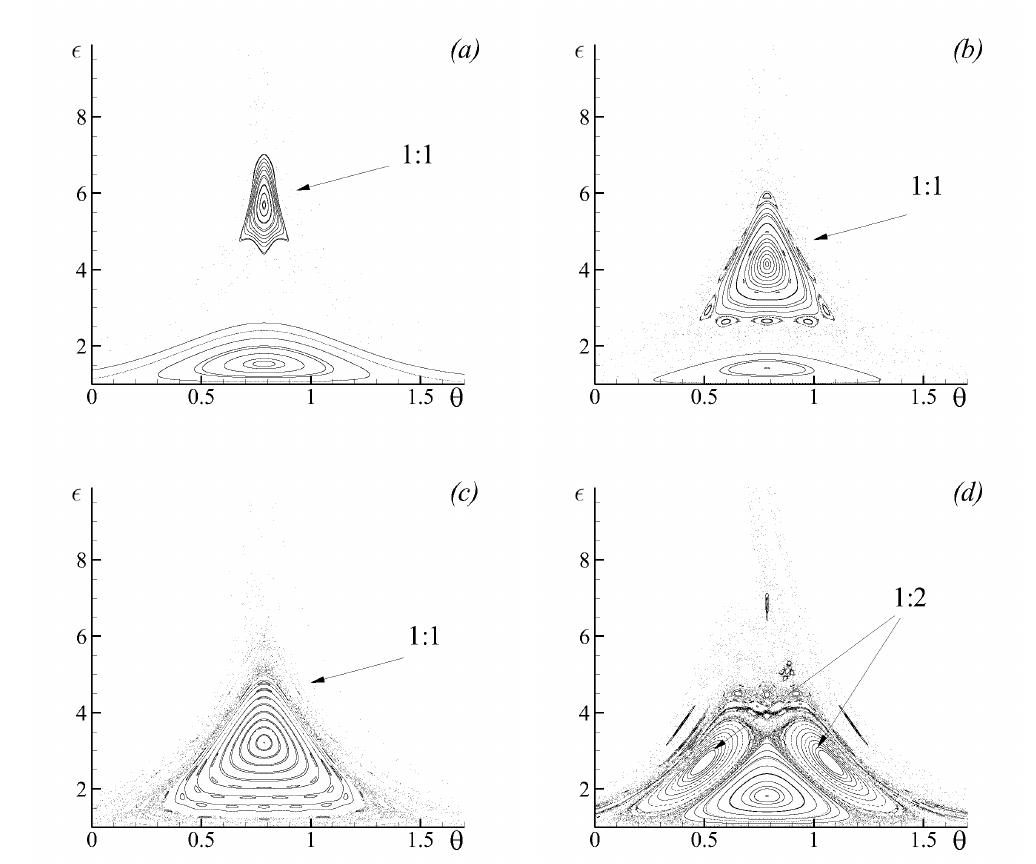
Figure 16. ( a – c ) Poincaré maps detailing the stability island induced by the nonlinear resonance 1 : 1 merging with the central stability region as the perturbation frequency is increased for the perturbation magnitude ε = 0.07: ( a ) 0.35; ( b ) 0.42; and ( c ) 0.47. ( d ) A similar process for the stability island 1 : 2 for ε = 0.2 and ν =